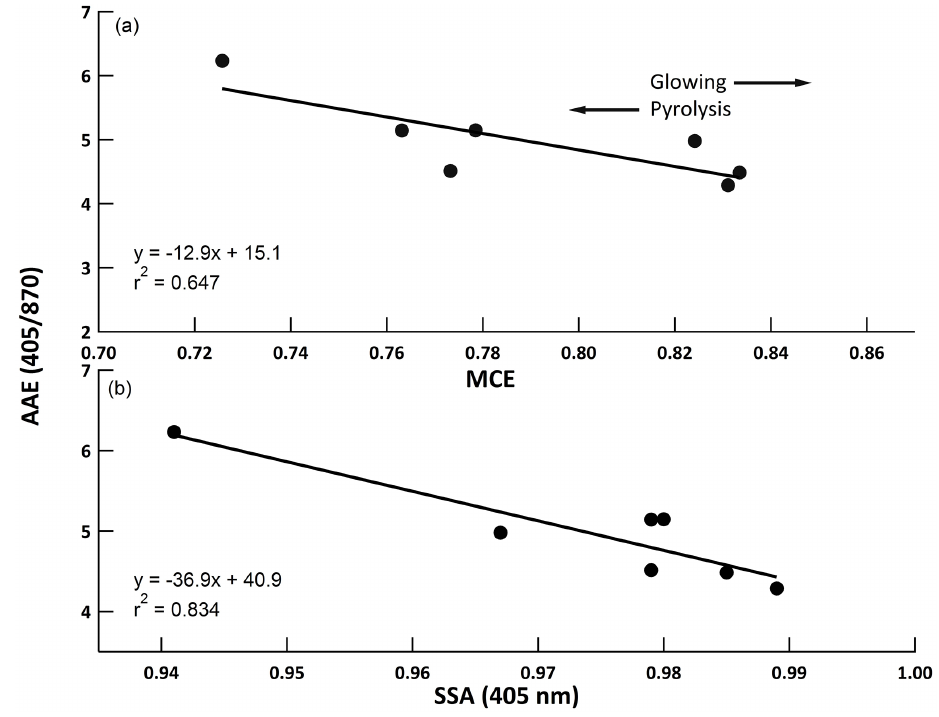
Figure 4. Correlations of (a) AAE vs. MCE and (b) AAE vs. SSA (405nm).